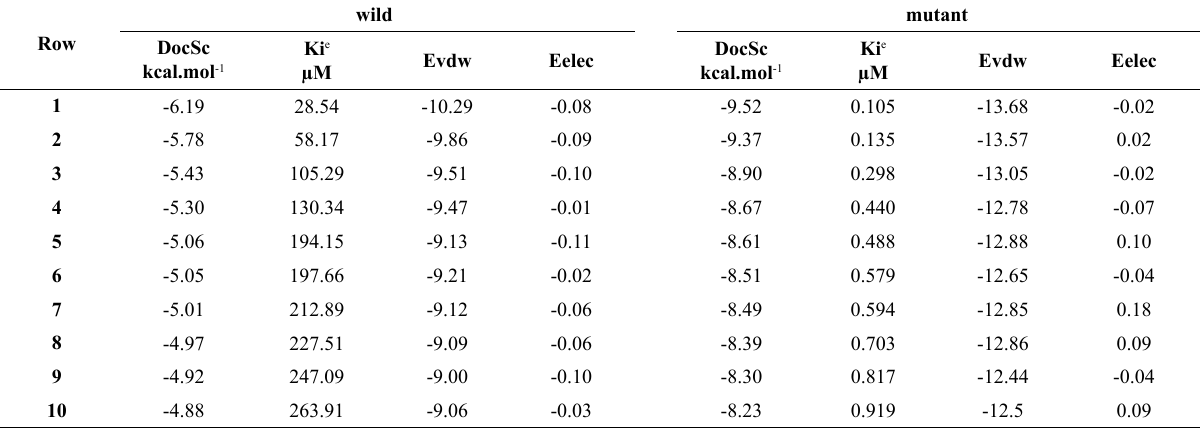
Table 2 - Docking results of wild and mutant 3CL pro of SARS-CoV-2 with inhibitor ligand.